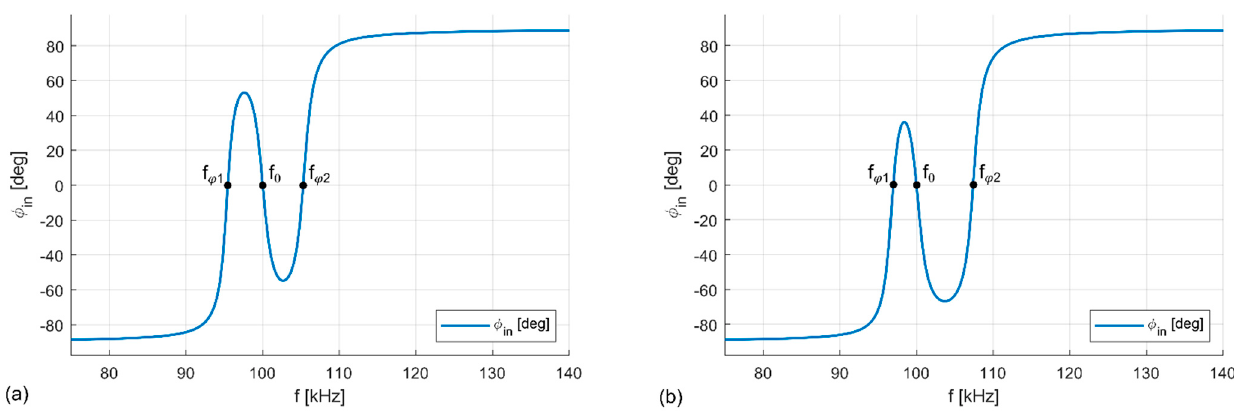
Figure 10. Frequency response shift due to detuning, illustrated on the displacement position of x = 60 mm. ( a ) Both sides are tuned to f 0 = 100 kHz. ( b ) The side resonance frequencies are given by Figure 9, i.e., f 0 p = 103.27 kHz and f 0 s = 100.13 kHz.